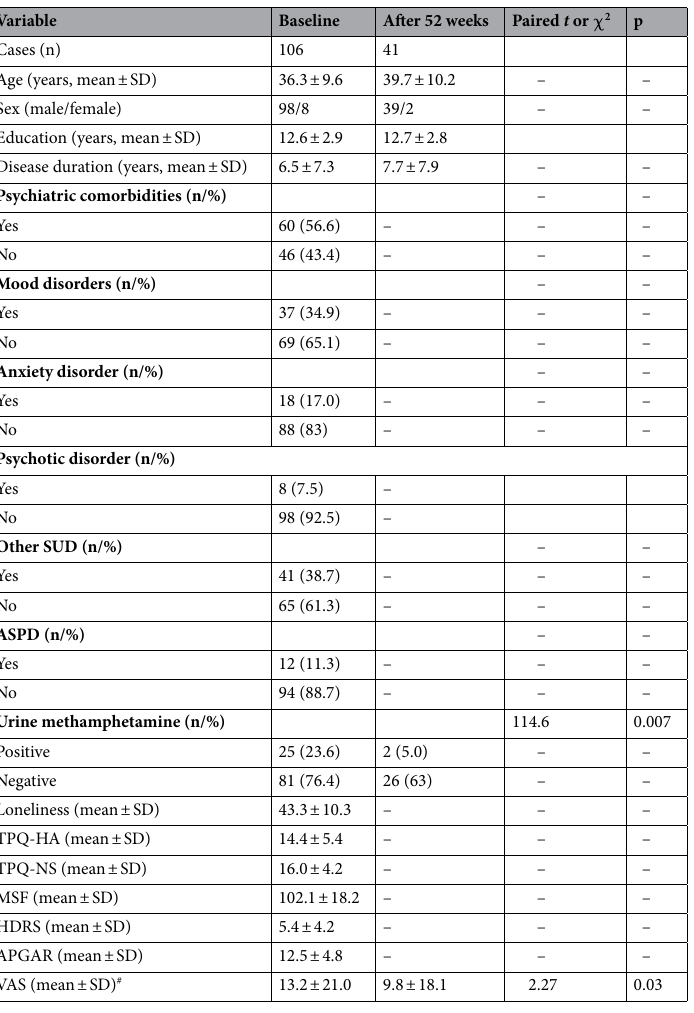
Table 1. Participant characteristics at baseline and endpoint. SUD substance use disorder, ASPD anti-social personality disorder, TPQ tridimensional personality questionnaire, HA harm avoidance, NS novelty